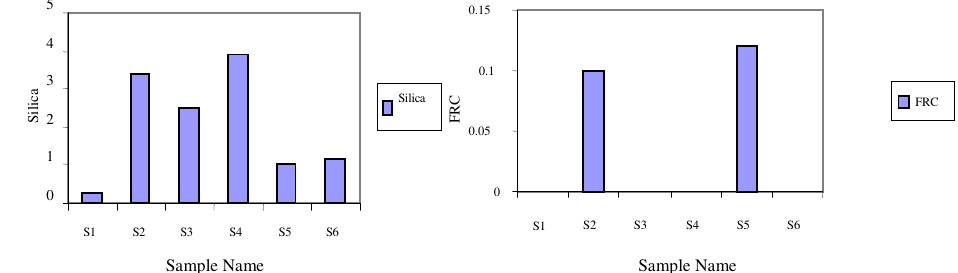
Figure 13. Silica in various sample Figure 14. FRC in various